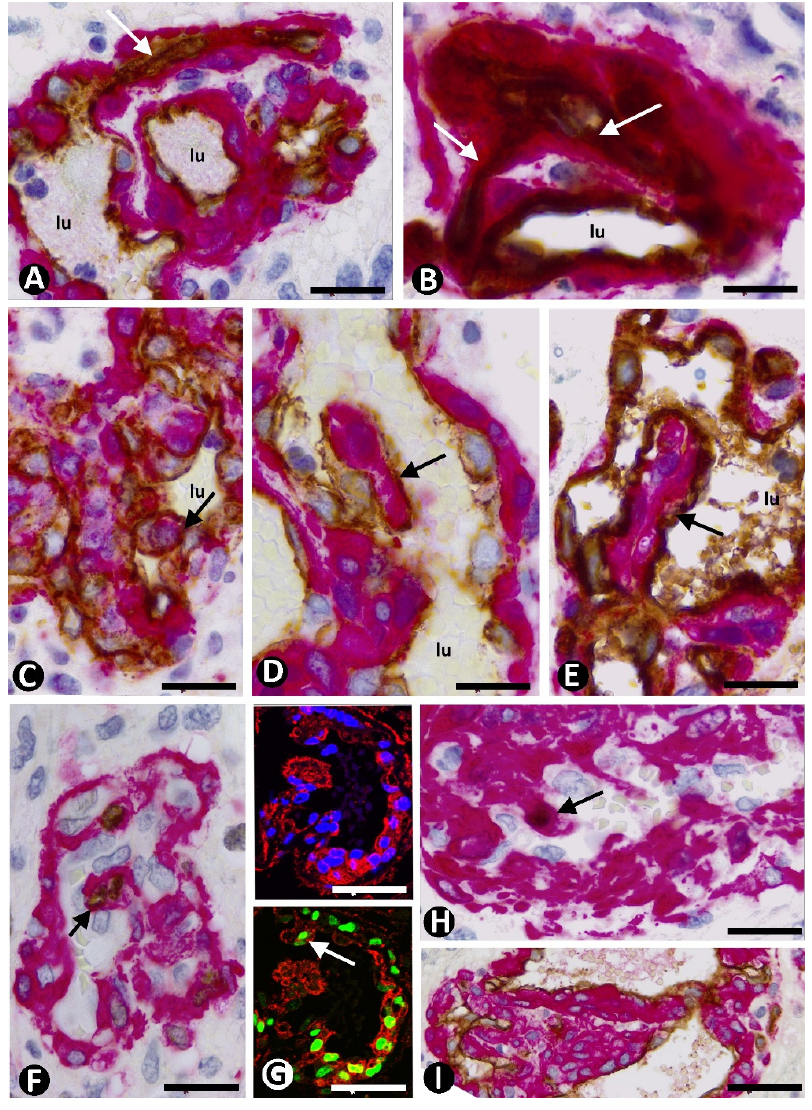
Figure 8. Loops, pillars, and pericyte proliferation in BM of GBM. ( A – E ) Vessel loops with virtual ( A , B , arrows) or partially opened ( C – E ) lumen are observed originating from mother vessels or other loops. Note that the loops with virtual lumen ( A , B , arrows) surround ITSs ( α SMA + pericytes, red). The loops with partially opened lumen form pillars, which are observed cross- ( C , arrow), obliquely, or longitudinally sectioned ( D , E , arrows). ( F – I ) Pericytes expressing Ki-67 and PHH3 in the core of pillars ( F – H , arrows) and widening of the pillar core ( I ). ( A – E , I ) Double immunochemistry for CD34 (brown) and α SMA (red). Hematoxylin counterstain. ( F , H ) Double immunochemistry for Ki-67 (brown) and α SMA (red). Hematoxylin counterstain. ( G ) Immunofluorescence for α SMA (1) and double immunofluorescence for PHH3 (green) and α SMA (red) (2). DAPI counterstain. Bar: ( A – F ) 20 µ m, ( G ) 45 µ m, ( H ) 40 µ m, and ( I ) 30 µ